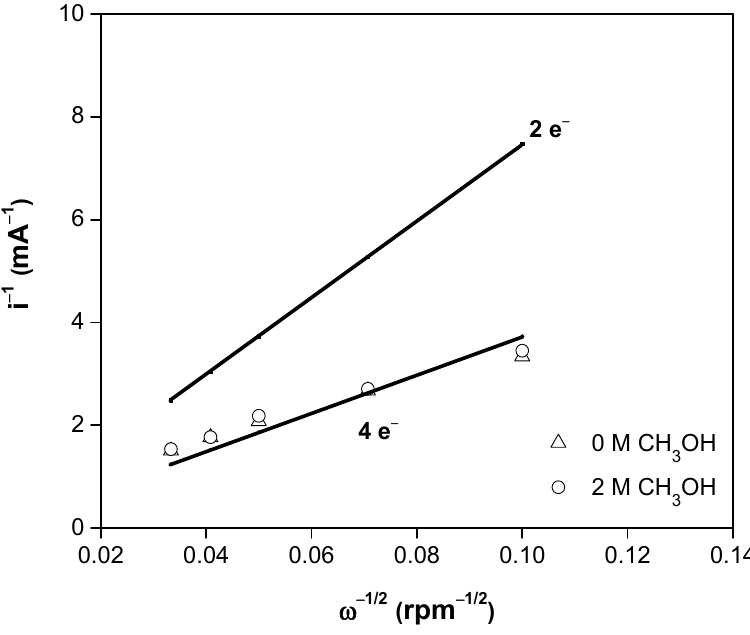
Figure 6. Theoretical (2 and 4 e − , solid lines) and experimental Koutecký–Levich plots of CoFeRu/C without ( ∆ ) and with ( ο ) 2 mol L − 1 methanol.